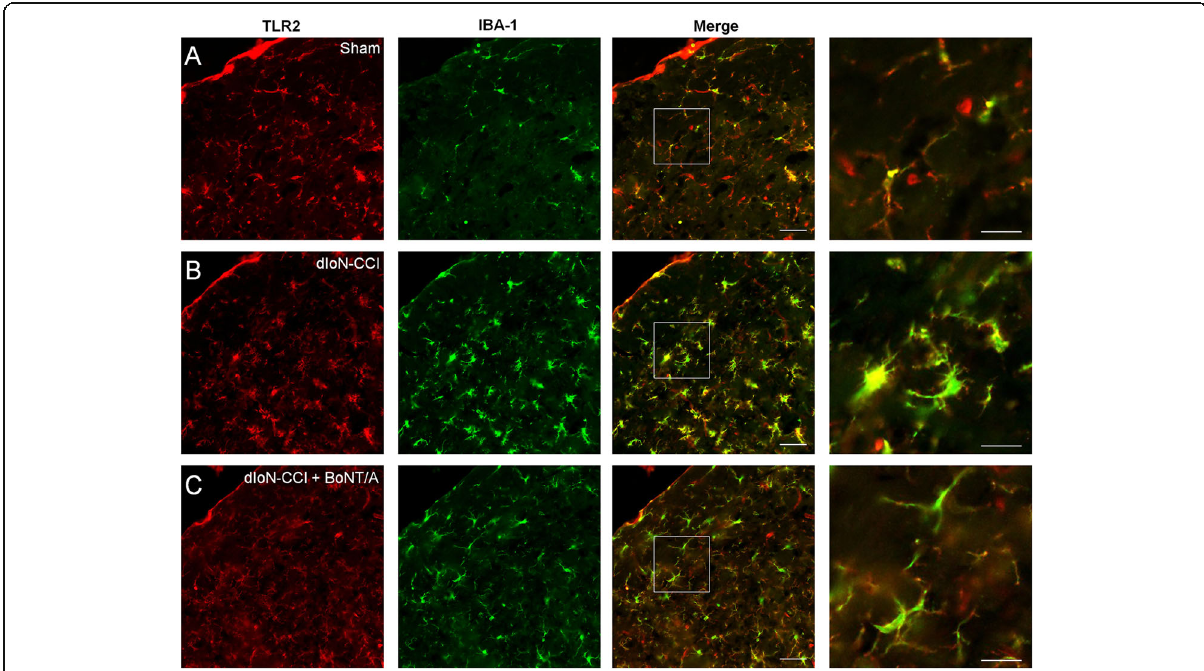
Fig. 8 Double immunostaining of TLR2 and IBA-1 in the ipsilateral TNC induced by dIoN-CCI surgery in mice. a Double immunostaining of TLR2 and IBA-1 in the ipsilateral TNC induced in sham animals. b Double immunostaining of TLR2 and IBA-1 in the ipsilateral TNC in dIoN-CCI animals. c On the day 5 following BoNT/A treatment (on day 19 following dIoN-CCI surgery), double immunostaining of TLR2 and IBA-1 in the ipsilateral TNC in dIoN-CCI + BoNT/A animals. Scale bar = 50 μ m, and the scale bar in the enlarged graph is 20 μ m. TNC, Trigeminal nucleus caudalis; dIoN- CCI, chronic constriction injury of distal infraorbital nerve; BoNT/A, botulinum toxin